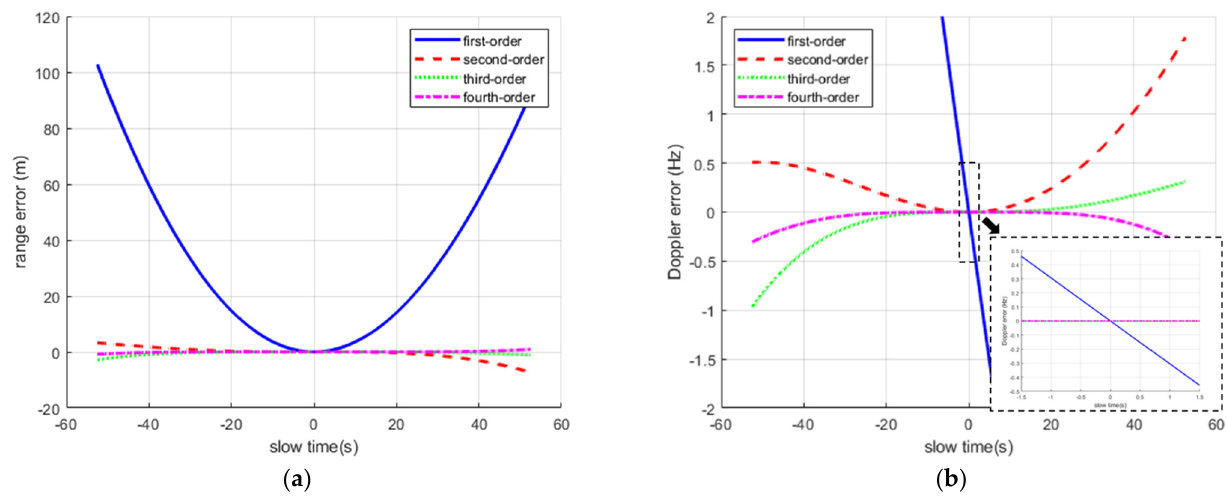
Figure 2. The fitting errors with different Taylor expansion orders: ( a ) range error; ( b ) Doppler error.